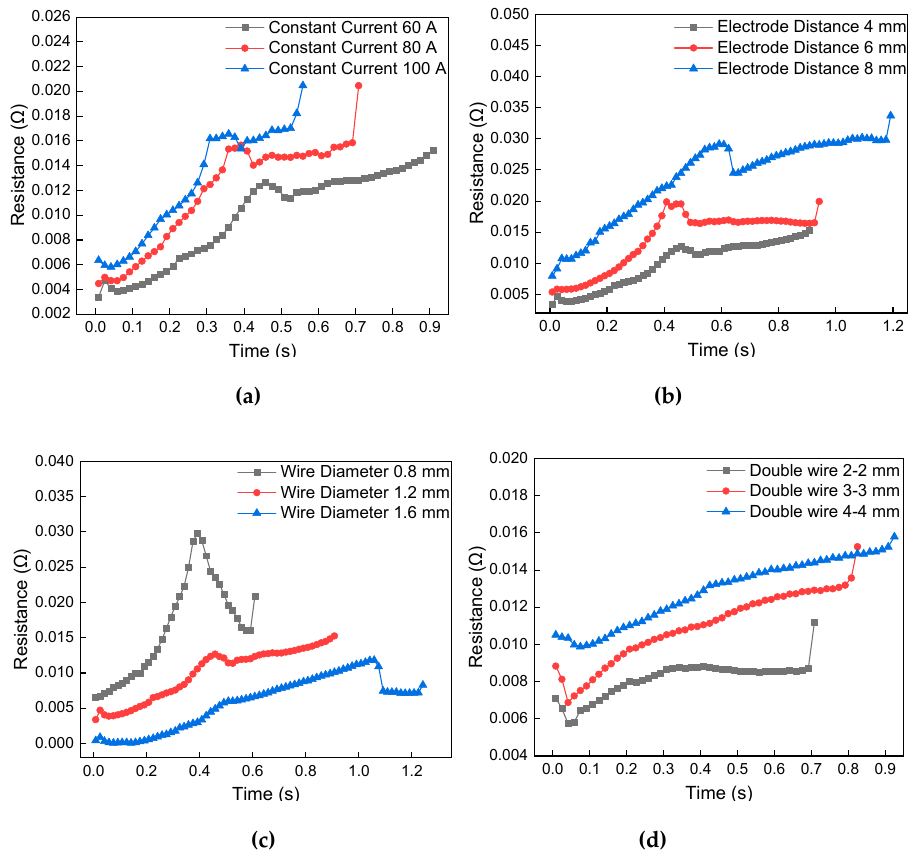
Figure 11. Dynamic resistance change of metal wire during melting. ( a ) Di ff erent short-circuit current; ( b ) electrode distance, ( c ) metal wire diameter, and ( d ) double metal wire length.